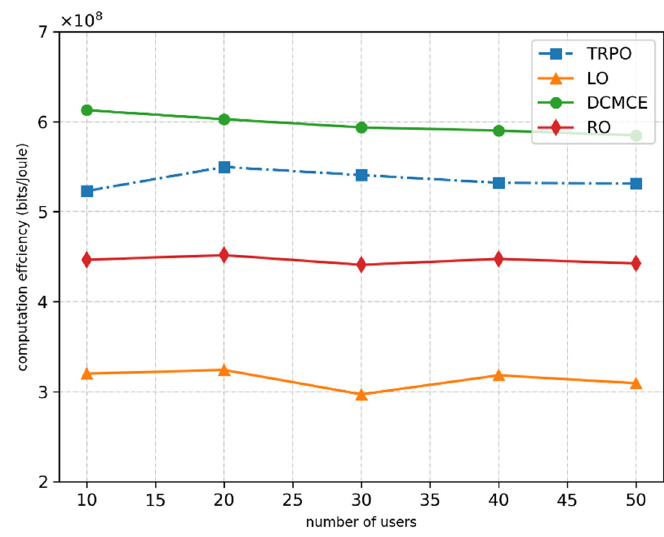
Figure 9. Computational efficiency of schemes versus MDs.